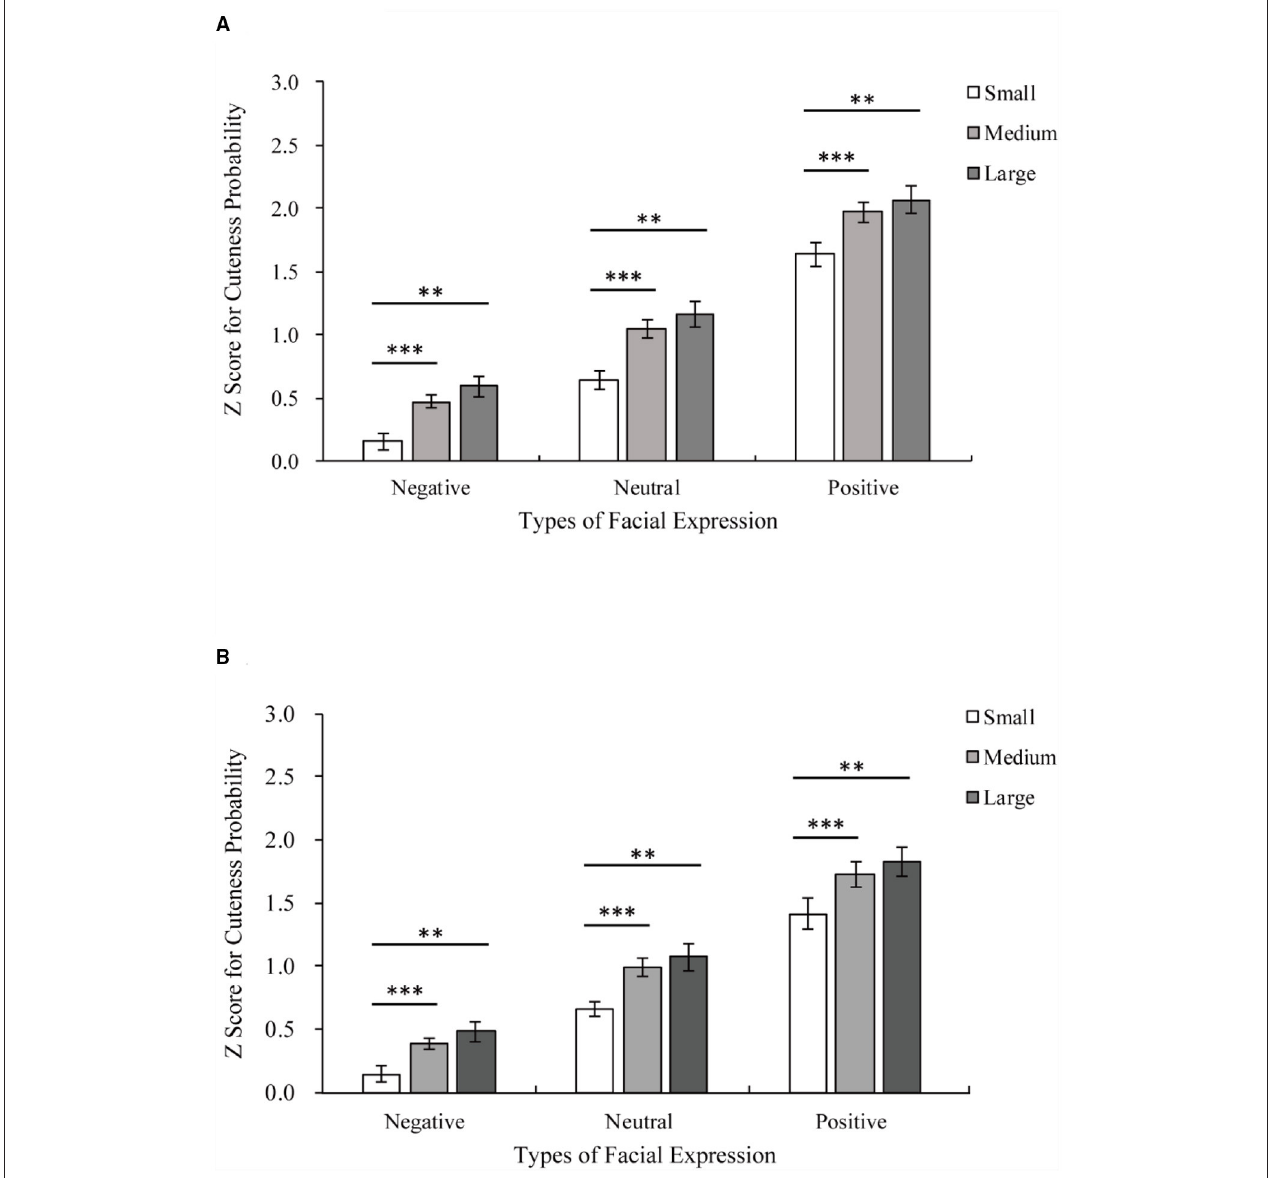
FIGURE 3 | Z score for cuteness probability of adults and infants with the same facial expression. On the horizontal, axis are the three facial expressions of adults or infants, and on the vertical, axis are z scores for cuteness probability. (A) The results of the adult group. Medium eye > small eye among the same facial expression, all *** p < 0.001; large eye > small eye among the same facial expression, all ** p < 0.01. (B) The results of the infant group. Medium eye > small eye among the same facial expression, all *** p < 0.001; large eye > small eye among the same facial expression, all ** p < 0.01. were randomly shown in the center (only one stimulus at a